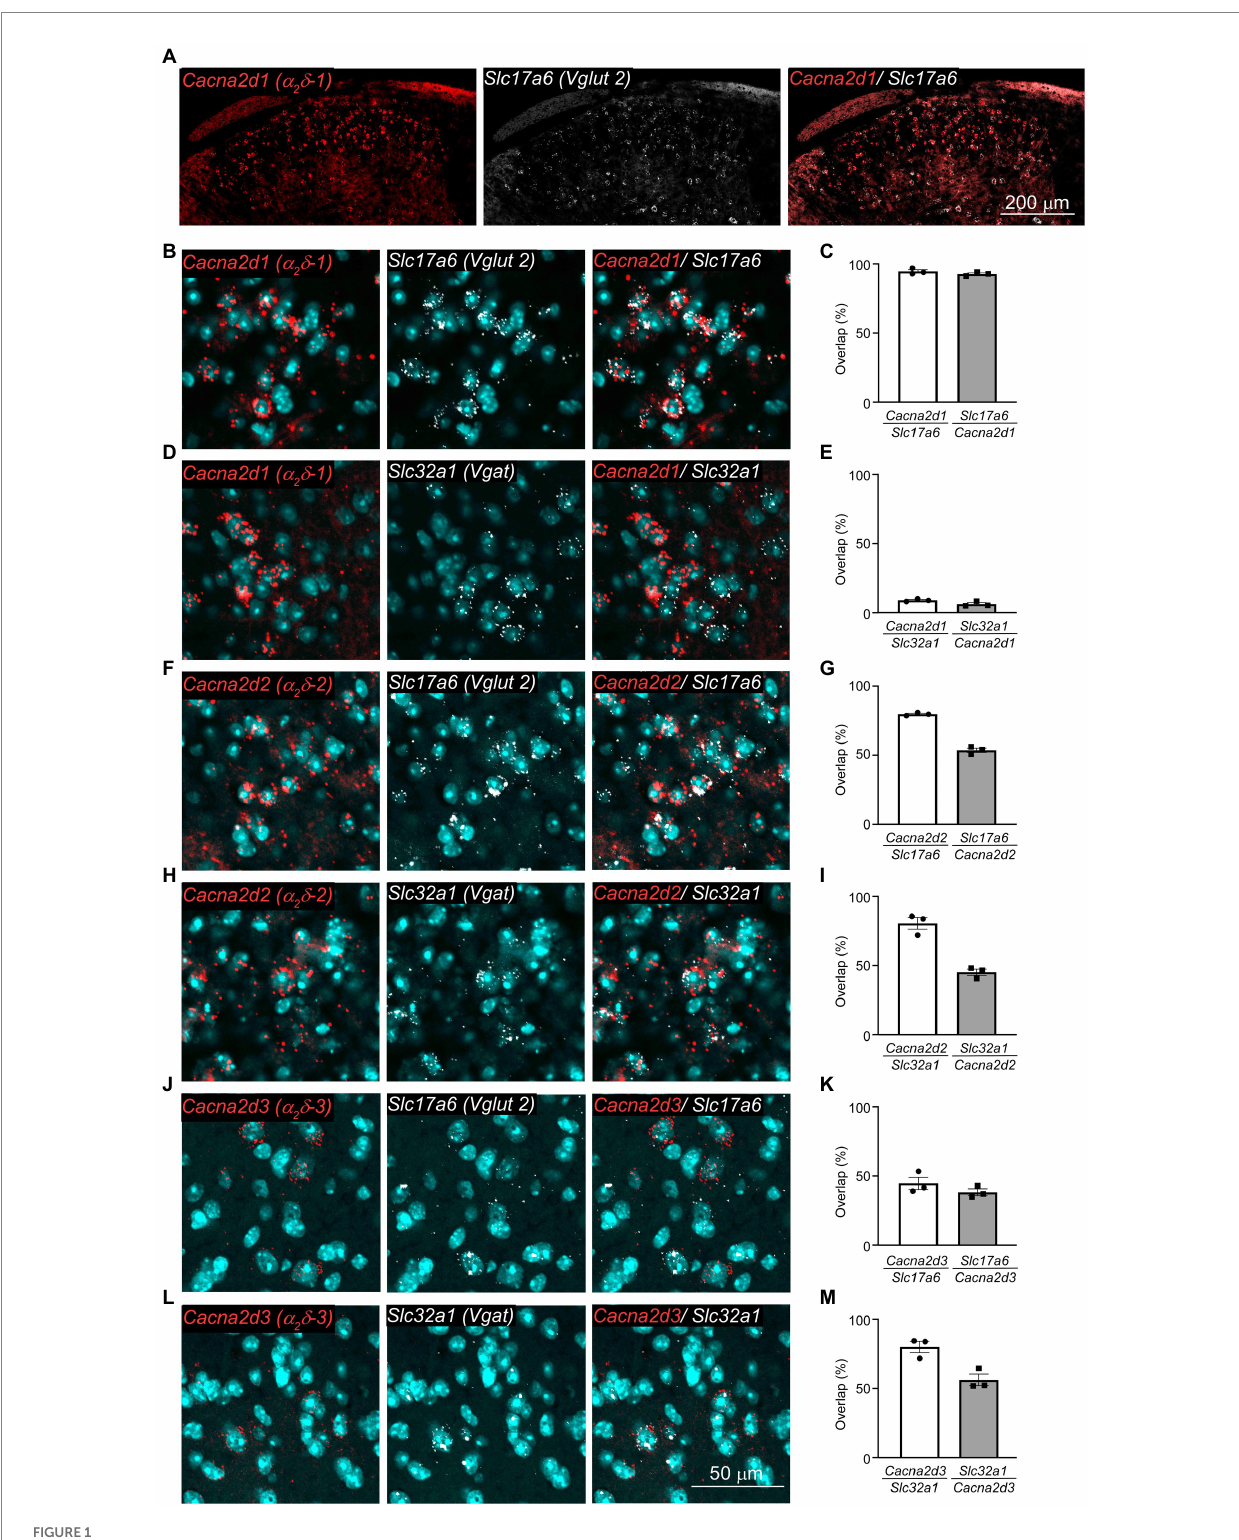
FIGURE 1 α 2 δ -1 mRNA was selectively expressed in excitatory neurons in the SDH. (A,B) Representative images of RNA scope in situ hybridization for mRNAs of Cacna2d1 (encoding α 2 δ -1 subunit, red) and Slc17a6 ( Vglut2 , gray) in the SDH of naïve mice. Low magnification images (A) and high magnification images (B) . (C) Summary of coexpression of Cacna2d1 and Slc17a6 . n = 3, 3 sections from 3 animals. (D) Representative images of Cacna2d1 (red) and Slc32a1 ( Vgat , gray) mRNAs. (E) Summary of coexpression of Cacna2d1 and Slc32a1 . n = 3, 3 sections from 3 animals. (F) Representative images of Cacna2d2 (encoding α 2 δ -2 subunit, red) and Slc17a6 (gray) mRNAs. (G) Summary of coexpression of Cacna2d2 and Slc17a6 . n = 3 sections from 3 animal. (H) Representative images of Cacna2d2 (red) and Slc32a1 (gray) mRNAs. (I) Summary of coexpression of Cacna2d2 and Slc32a1 . n = 3, 2–3 sections from 3 animals. (J) Representative images of Cacna2d3 (encoding α 2 δ -3 subunit, red) and Slc17a6 (gray) mRNAs. (K) Summary of coexpression of Cacna2d3 and Slc17a6 . n = 3, 2–3 sections from 3 animals. (L) Representative images of Cacna2d3 (red) and Slc32a1 (gray) mRNAs. (M) Summary of coexpression of Cacna2d3 and Slc32a1 . n = 3, 2–3 sections from 3 animals. Data are mean ± SEM of averaged data from individual